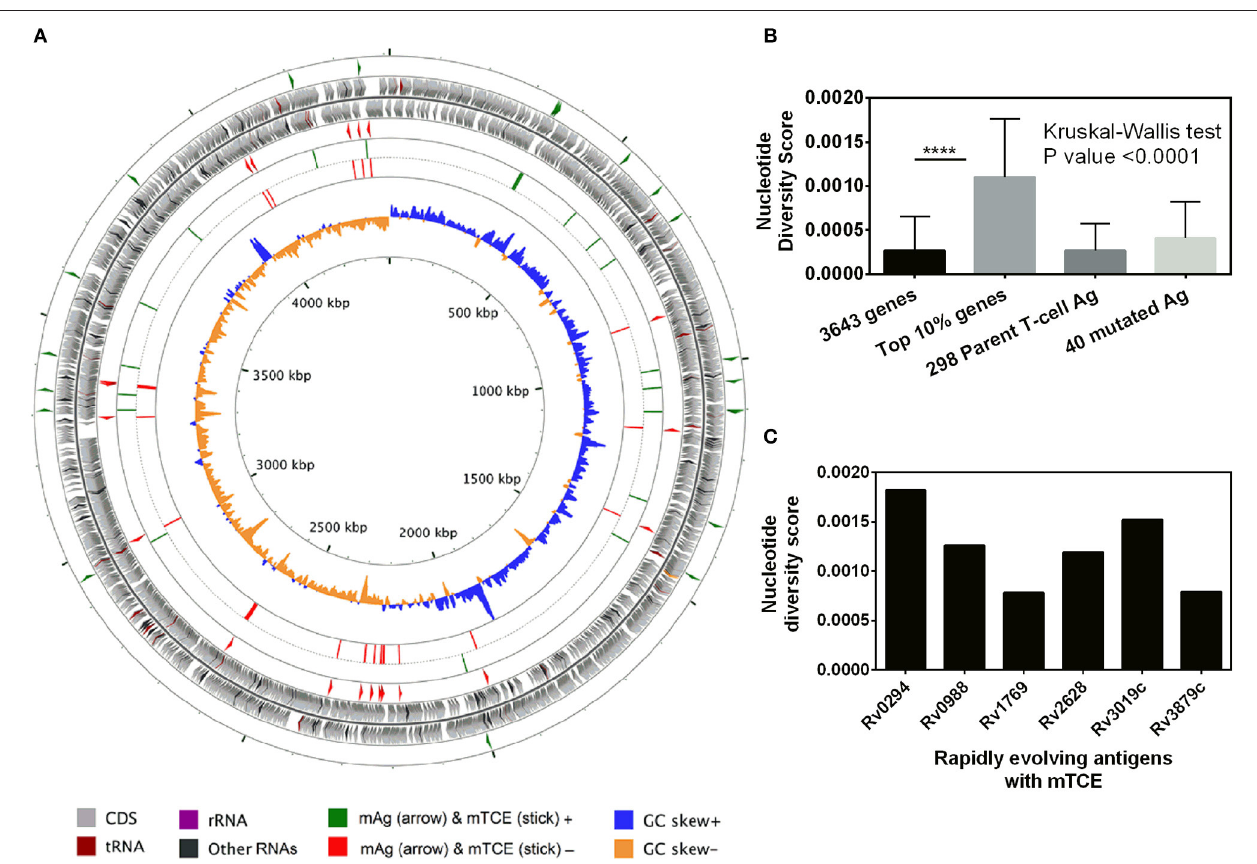
FIGURE 3 | Genetic diversity of 79 Mtb strains from India. (A) The scale of the chromosome (in nucleotides, according to the reference Mtb strain H37Rv) is labeled on the innermost ring. From the outer to the inner concentric circle of the chromosome: Circles 1–2 and 3–4, genes with forward and reverse directions are indicated as right and left arrows, respectively. Circles 1 (green) and 4 (red) exemplify the locus of 40 mutated T-cell antigens, which encode mutated T-cell epitopes identified in this study. Circles 2–3 (gray) depict all genes from H37Rv. Circles 5 (green) and 6 (red) show the locus of 64 mutated T-cell, epitopes in the forward and reverse strands, lining their respective genes in circles 1 and 4, respectively. Circles 7 and 8 represents the GC skew of all the genes of H37Rv. (B) Bar graph showing nucleotide diversity scores of genes from different categories (**** p- value < 0.0001). (C) Bar graph showing nucleotide diversity scores of six genes encoding mTCEs that fall within the top 10% of nucleotide diversity scores across all 3,643 genes (excluding repetitive genes) encoded by the 79 Mtb strains from India, and therefore designated as rapidly